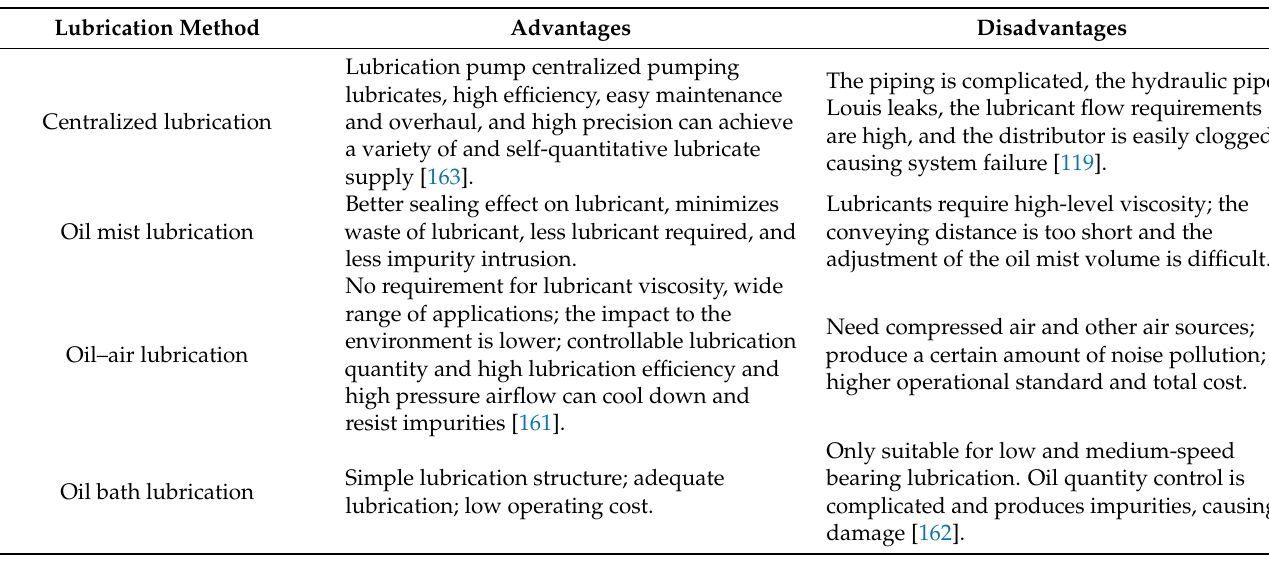
Table 6. Common lubrication methods for wind turbine bearings